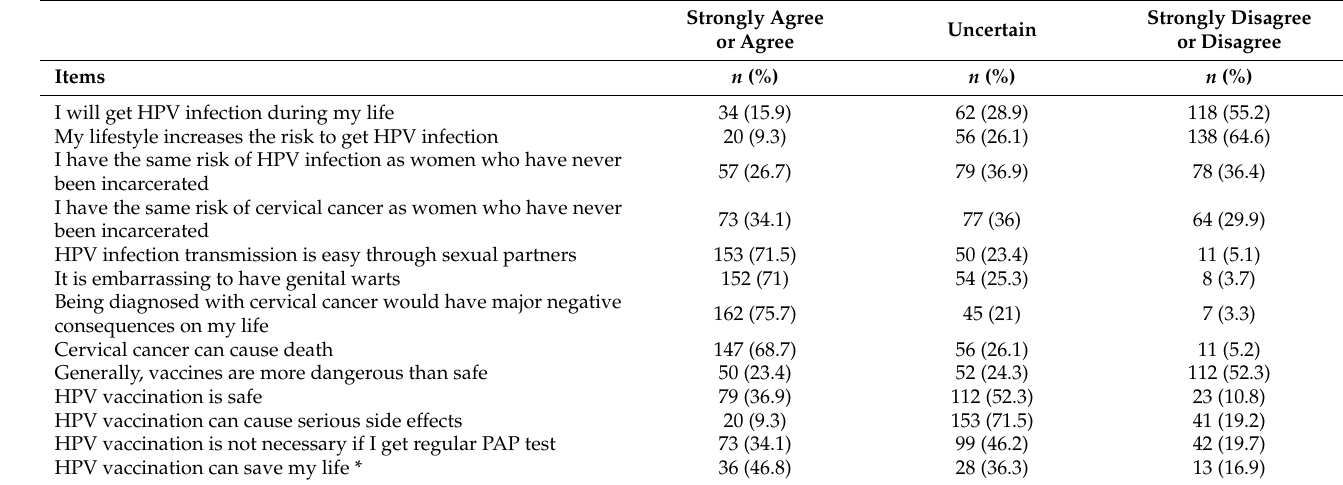
Table 2. Attitudes and beliefs towards HPV infection, cervical cancer, and related preventive measures.